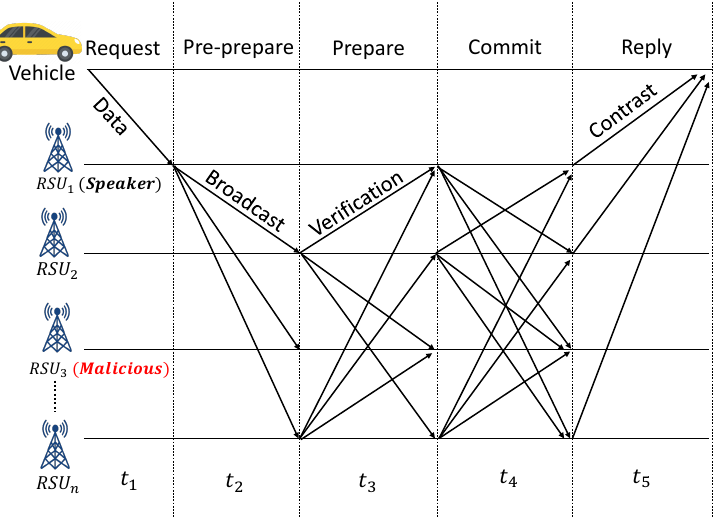
Figure 3. Consensus process in record pool smart contracts (RPSC).